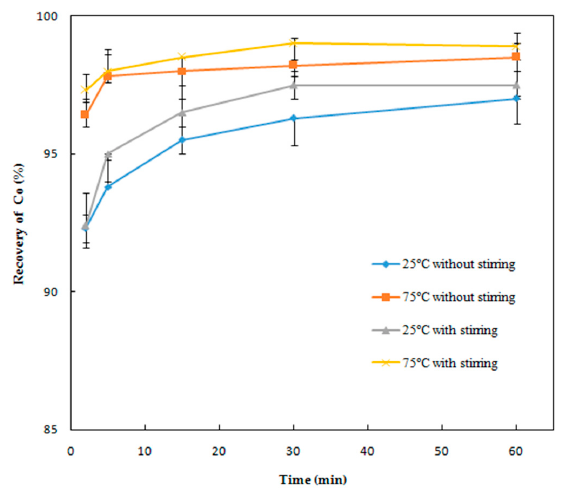
Figure 9. Effect of reaction time on the recovery of Co.